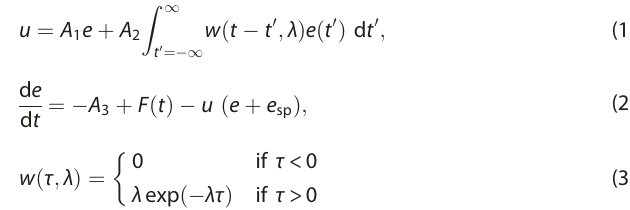
Here, Δ = 15 minutes is the interval between two measurements of the FreeStyle Libre fl ash glucose